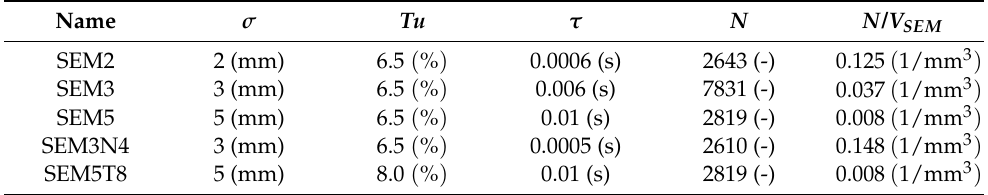
Table 2. SEM box